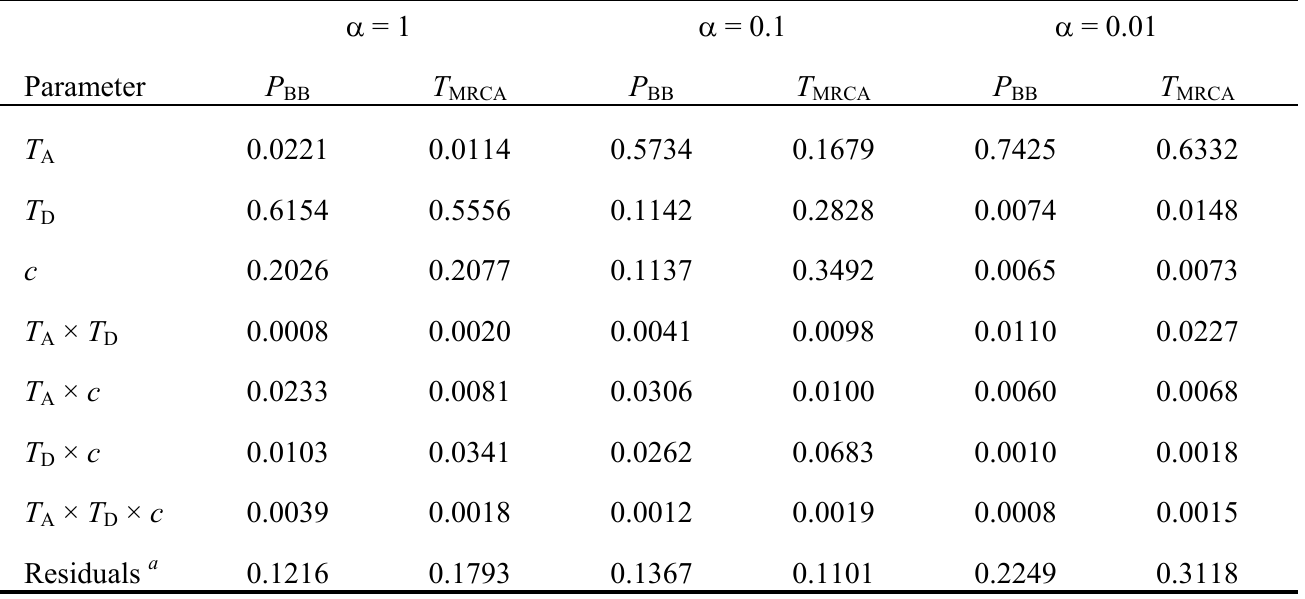
Table 2. Analysis of variance for IAA model parameters for constant size population (  = 1), mild founder event (  = 0.1), and strong founder event (  = 0.01). See Table 1 for detailed explanation of